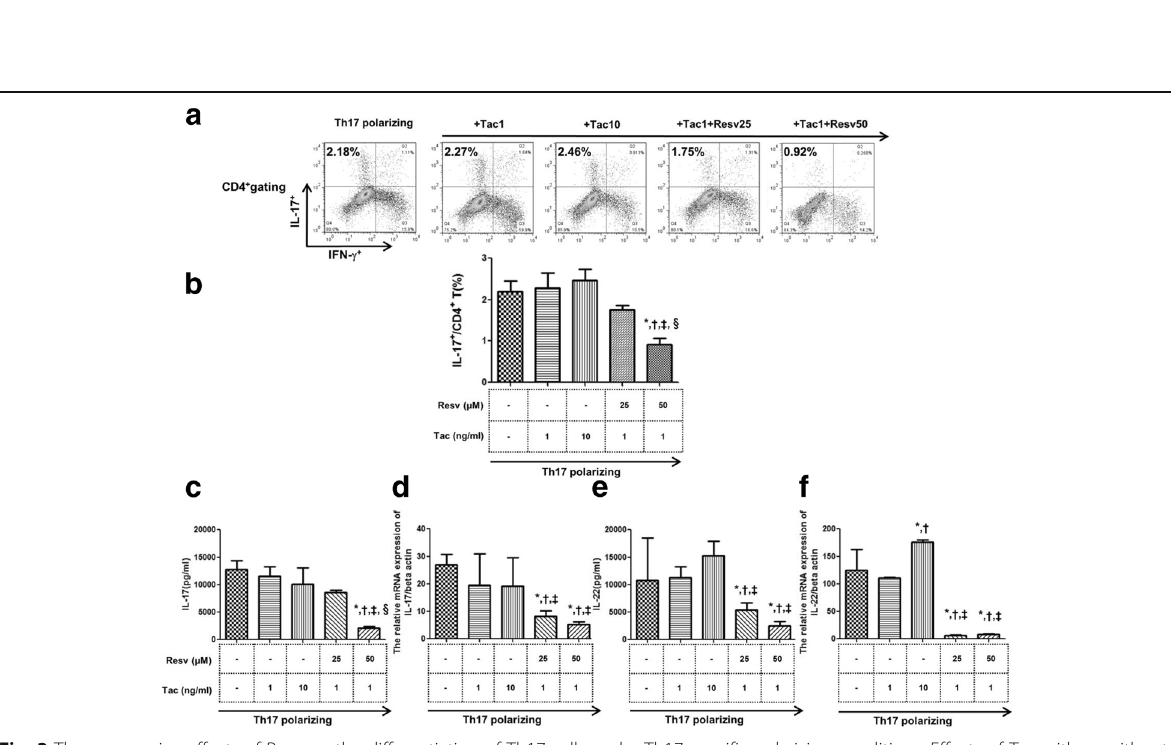
Fig. 3 The suppressive effects of Resv on the differentiation of Th17 cells under Th17 specific polarizing conditions. Effects of Tac with or without Resv on CD4 + T cells isolated from PBMCs of healthy donors and cultured under Th17 polarizing conditions. ( a ) The percentage of CD4 + T cells producing IL-17 was measured by flow cytometry. ( b ) The effects of Tac with or without Resv on IL-17 + /CD4 + T cells, and effects on ( c ) IL-17 levels (or ( e ) IL-22) and on the expression of ( d ) IL-17 (or ( f ) IL-22) mRNA. *P < 0.05 vs. Th17 polarizing † P < 0.05 vs. Tac 1 ng/mL group ‡ P < 0.05 vs. Tac 10 ng/mL group § P < 0.05 vs. Tac 1 ng/mL + Resv 25 μ M group. Resv, Resveratrol; Tac, tacrolimus